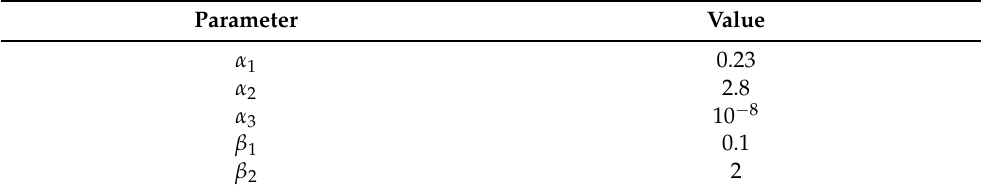
Table 5. Adaptation